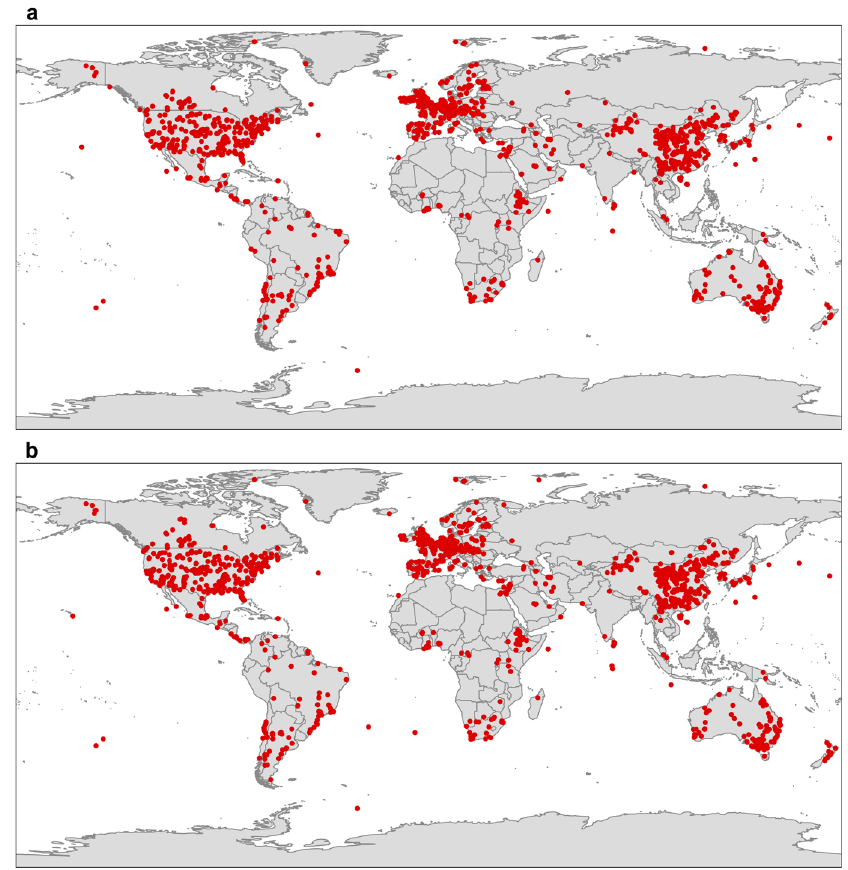
Fig. 1 Locations of the soil seed bank studies included in our database. a Diversity; b